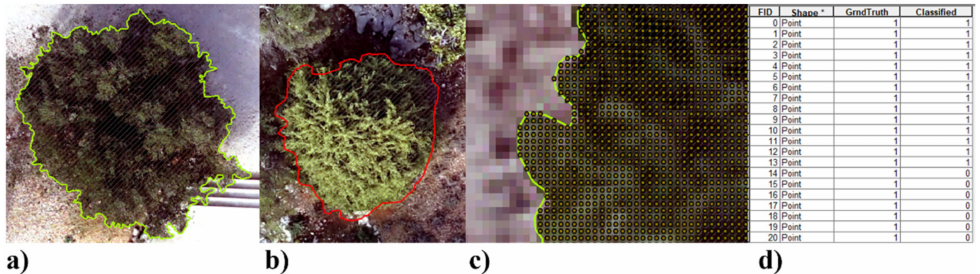
Figure 6. Accuracy assessment steps: ( a ) RT vectorization; ( b ) FT vectorization; ( c ) fishnet; ( d ) attribute